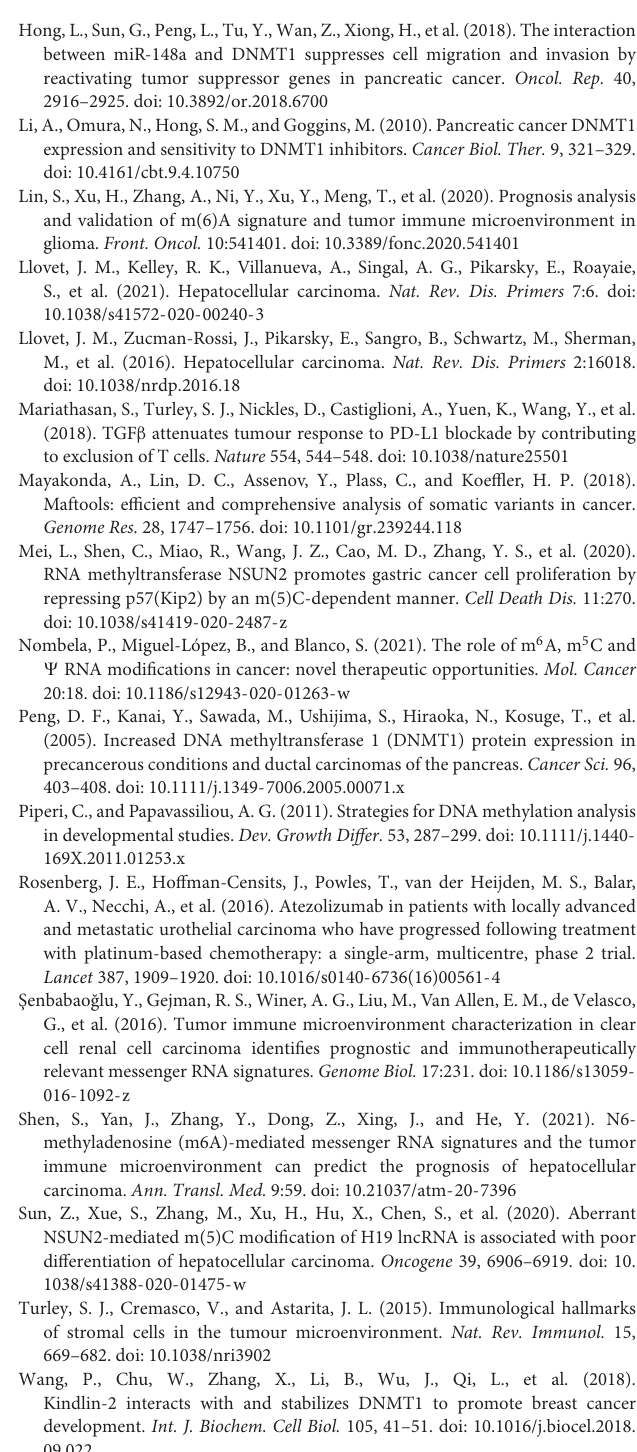
Supplementary Table 3 | Activation states of biological pathways in distinct m 5 C modification patterns by GSVA. Supplementary Table 4 | Correlation between DNMT1 expression and clinicopathological